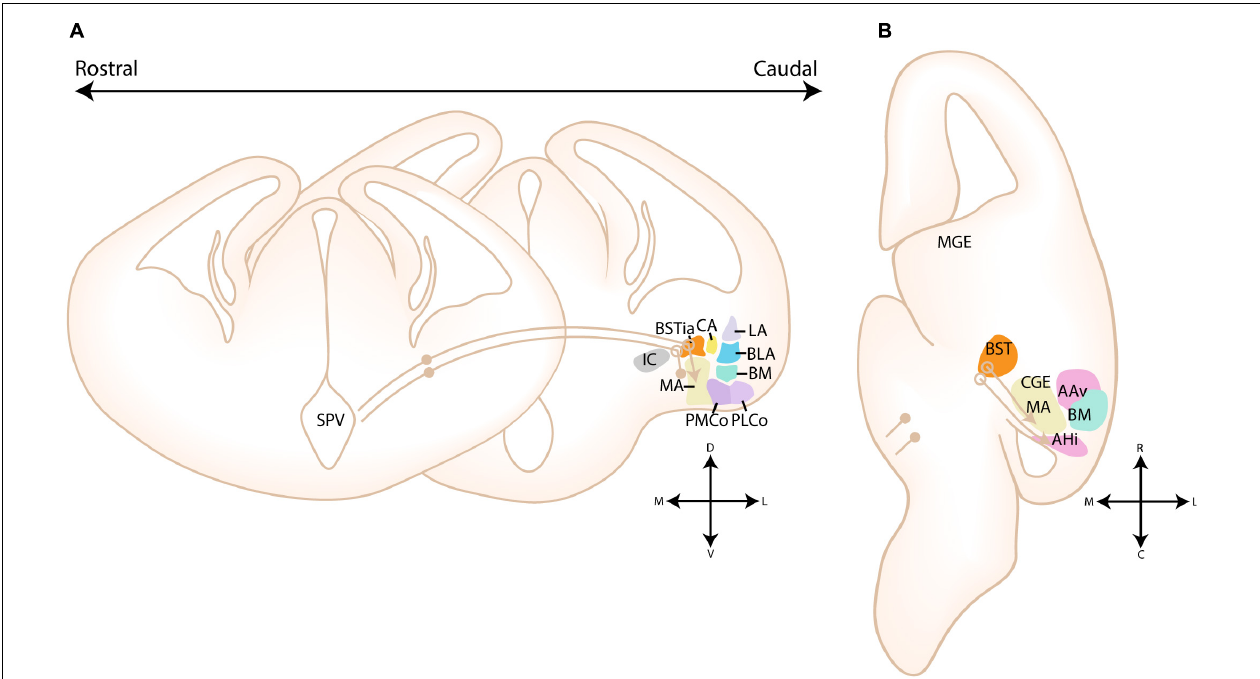
FIGURE 11 | Migration routes from hypothalamic domains toward the amygdala. (A) Rostrocaudal gradient of schematic coronal sections showing the migratory routes of supraopto-paraventricular hypothalamus-derived cells toward the amygdala. Two parallel migratory streams, including a rostrodorsal stream originating in the telencephalon-opto-hypothalamic domain (TOH, Otp+/Foxg1+) and a caudoventral stream from more central domains of the supraopto-paraventricular hypothalamus (SPV, Sim1+), emerge from the SPV and course dorsolaterally toward the medial part of the bed nucleus of the stria terminalis (BSTM). After entering the telencephalon, a continued caudoventral migration delivers the TOH-derived cells to the medial amygdala (MA, shown), anterior and/or posteromedial cortical amygdala (ACo, PMCo, resp.) and ventral anterior amygdala area (AAv). The latter two are not visible on the scheme due to their more rostral position. Hypothalamic Sim1+ cells from other SPV domains instead migrate around the MA toward the amygdalo-hippocampal interface (AHi), basomedial amygdala (BMA) and layer two of the nucleus of the lateral olfactory tract (nLOT2). Since this migratory stream courses more caudally, the migration toward AHi, BMA, and nLOT2 is not visible on this scheme. Positions where cells go in the slide are shown with a filled circle, positions where cells come out of the slide are shown with an open circle. (B) A schematic horizontal scheme showing the migration from the SPV toward the MA and AHi. Part of the migration route is located more dorsally than the scheme and thus not visible. Sim1+ cells pass the MA and instead migrate toward the AHi, after which they continue their migration toward BMA and nLOT2 as shown in Figures 10D,E . TOH-derived cells instead invade the MA, ACo/PMCo and AAv. Positions where cells go in the slide are again shown with a filled circle,